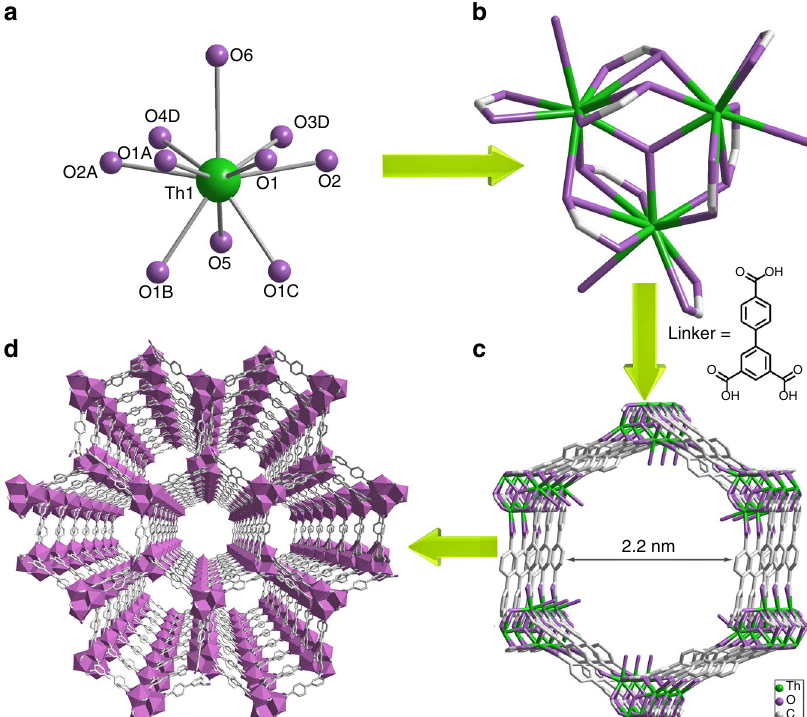
Fig. 1 Crystal structure depictions of SCU-8. a Coordination geometry of Th 4+ , b The cationic cluster of [Th 3 (COO) 9 O(H 2 O) 3.78 ] + as the SBU, c Hexagonal tubular channels in the structure, d A view of the cationic mesoporous framework structure along c axis. The carboxylate group (O3, O4), coordinating water (O6) and bptc 3 − ligand are disordered, and only the major conformations are shown. Atom colors: Th = green, O = purple, C =